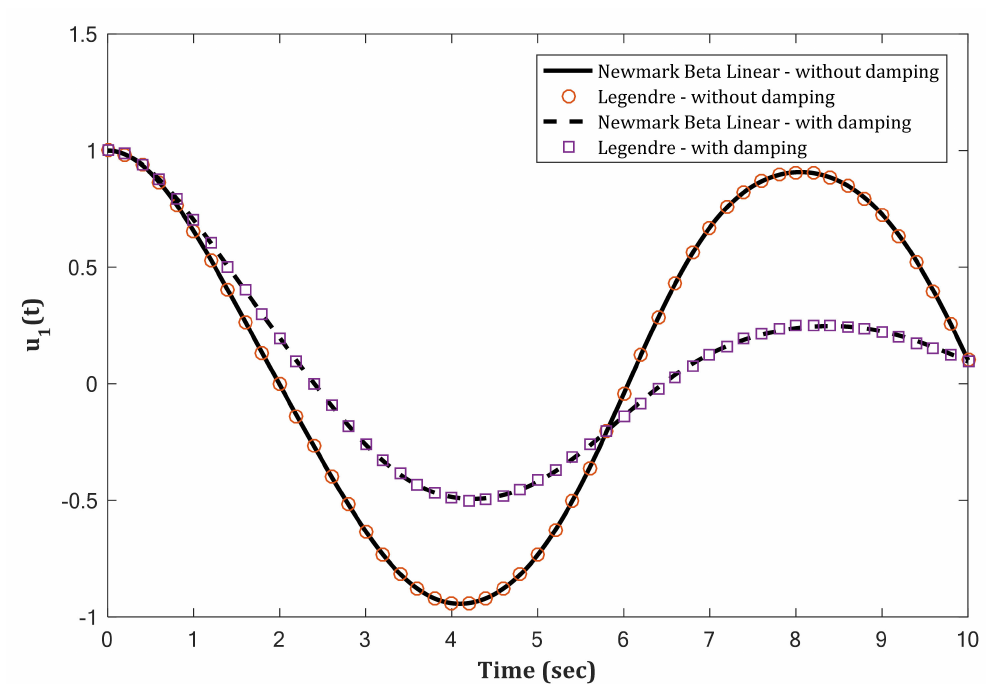
Figure 13. Free vibration analysis of a 5DOF system. Comparison of u 1 ( t ) as a function of time, as obtained using the LGM method or the linear Newmark- β method.